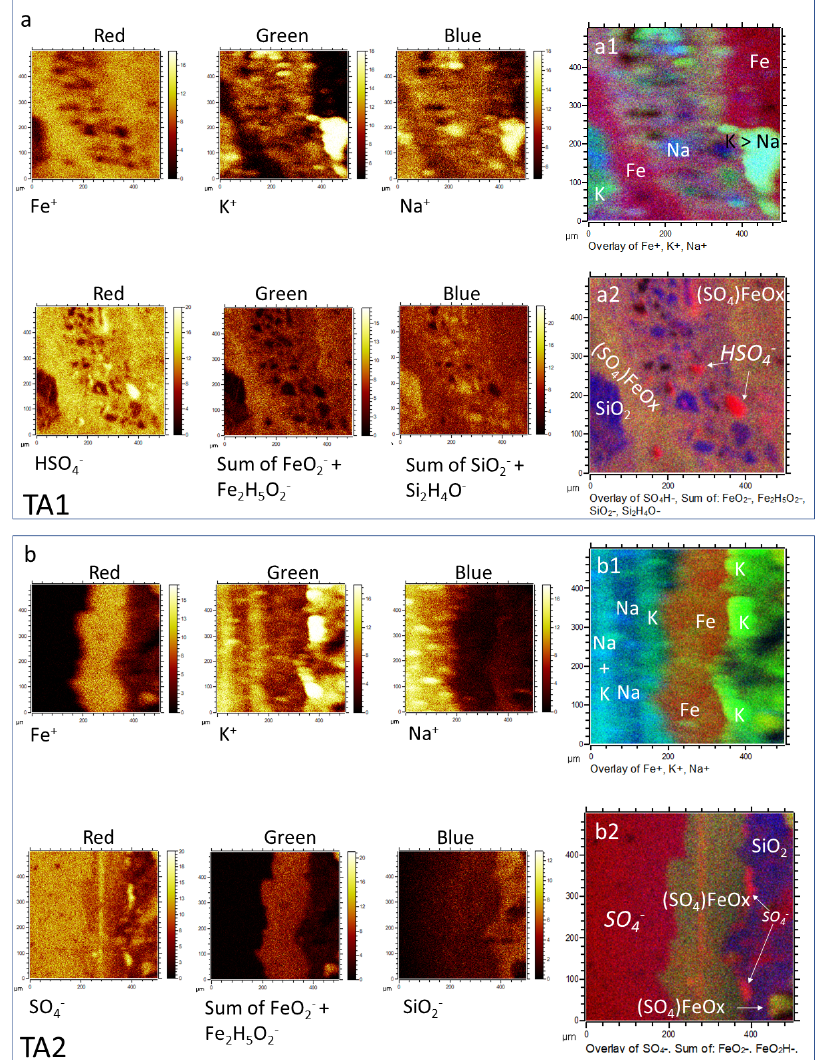
Figure 3. Characterization of the layer mineral composition through the distribution of inorganic cations (Fe + , Na + , and K + ) and anions (SO 4 − , FeO 2 − + Fe 2 H 5 O 2 − , and SiO 2 − + Si 2 H 4 O − ) through a red, green blue graph (RGB) merging different ion images. Inorganic composition in TA1 ( a ) and TA2 ( b ) showing five distinctive mineral areas like ferruginous and sulfatic-rich ((SO 4 )FeOx), silica-rich (SiO 2 ), sulfur enriched (SO 4 − ), and heterogeneous, which reflects a greater compositional variability of the microbrecciated layer. They follow the occurrence of the different layered units described in Figure 2b; where (1) ferruginous and sulfatic-rich composition meet the microlaminated layer (ma) and the matrix of the microbrecciated layer (mb), (2) the silica-rich area follows the fibrous and cryptocrystalline layer (fb), and (3) and the sulfate area depleted in Fe corresponds with the glassy layer (ms). Furthermore, the compositionally heterogeneous area with SiO 2 and SO 4 − correspond with different microclasts that are embedded in the microbrecciated layer (mb). The cation distribution provides some additional information regarding the geochemical composition of the different units. It is observed an association between K + and Na + with the silica and sulfate-rich and iron-depleted areas. Indeed, K + is highly associated with the crenulated unit (cr in Figure 2b) that is enriched in phosphate (Figure 4a,b). K + and Na + also enhance the internal microstructure (b2) of the glassy layer (ms) where they occur forming thin laminas and enlarged nodular-like appearance that meets the filamentous structures shown in Figure 2b. The ToF-SIMS images were obtained from a rasterized surface area of a 500 µ m